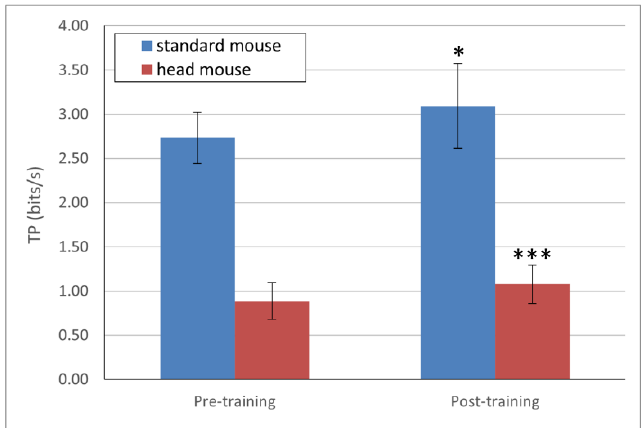
Figure 2. MT versus ID e for all subjects. The dotted lines show the best fits by the least squares ’ method for each condition.